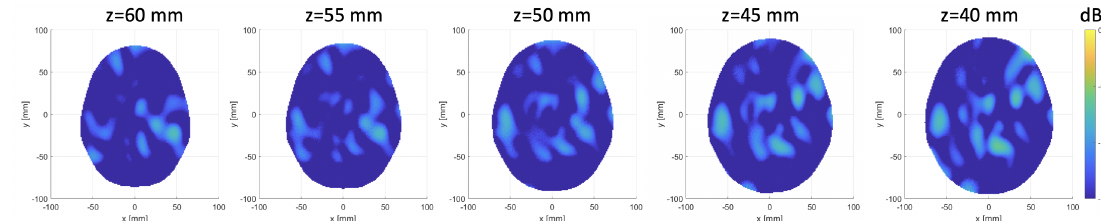
Figure 12. Horizontal cross-sections at various levels of the obtained 3D image, differentiating two sets of different measurements of the same scenario; images normalized with respect to the maximum value of Figure